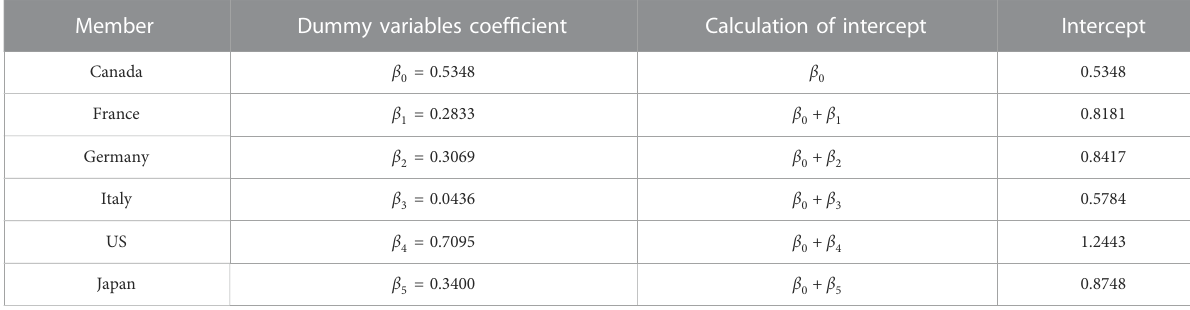
TABLE 7 The calculation of intercept values for each member of G7 geopolitical